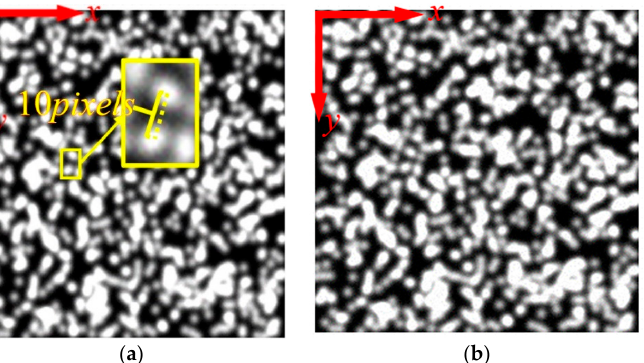
Figure 3. Speckle pattern: ( a ) without noise; ( b ) Gaussian white noise with zero mean and variance 5.